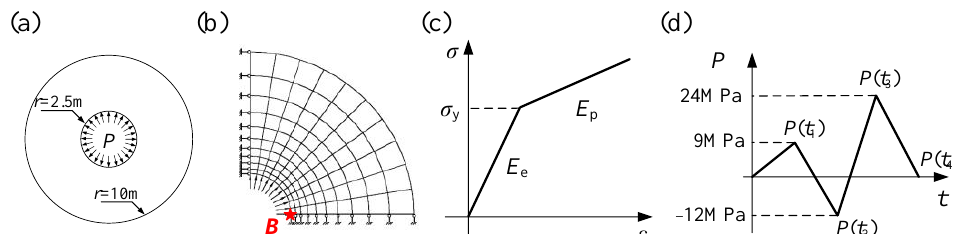
Figure 3. Thick wall cylinder problem: ( a ) thick wall cylinder subjected to internal load, ( b ) the finite element mesh and symmetrical boundary condition, ( c ) stress-strain diagram for bilinear material model, and ( d ) cyclic pressure loading path.